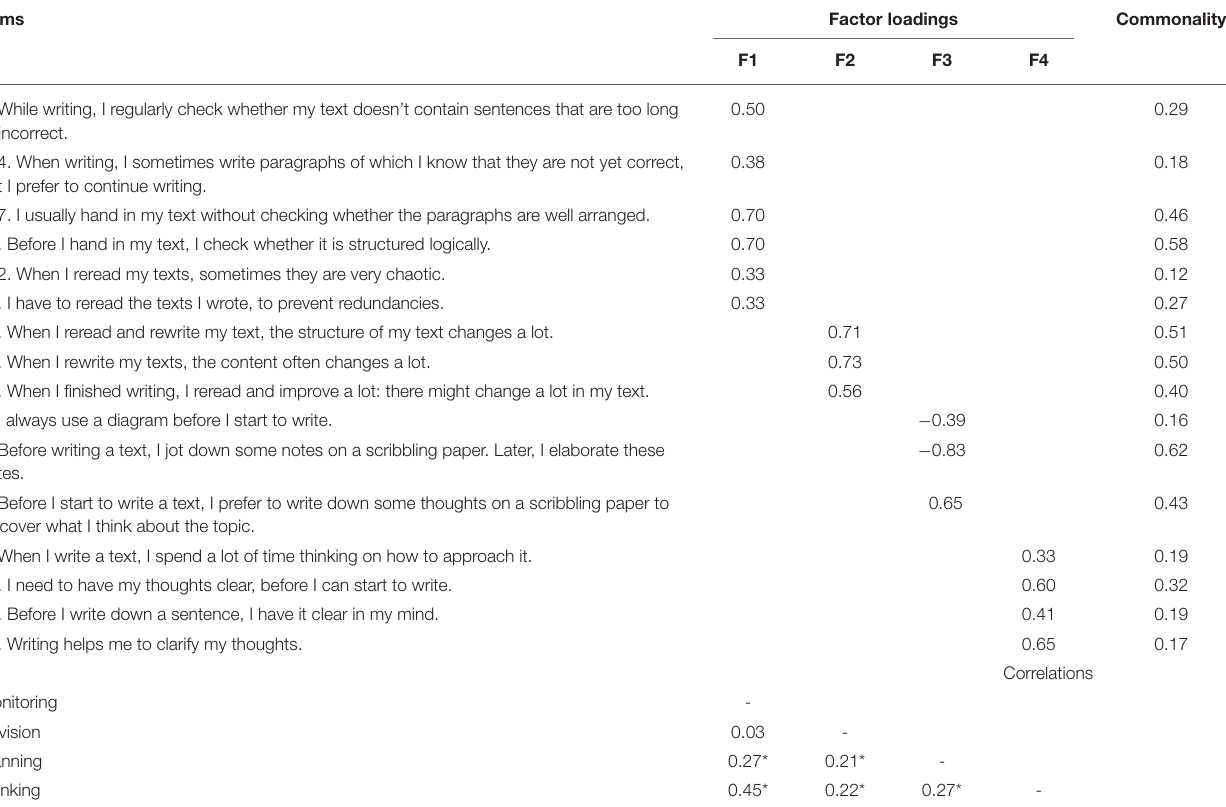
TABLE 1 | Exploratory factor analysis (EFA) of the